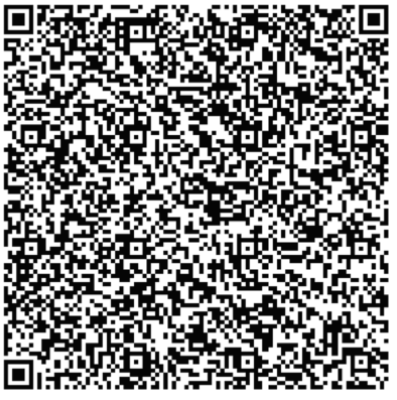
Figure 9. An example of a QR code that is generated by QuickCash